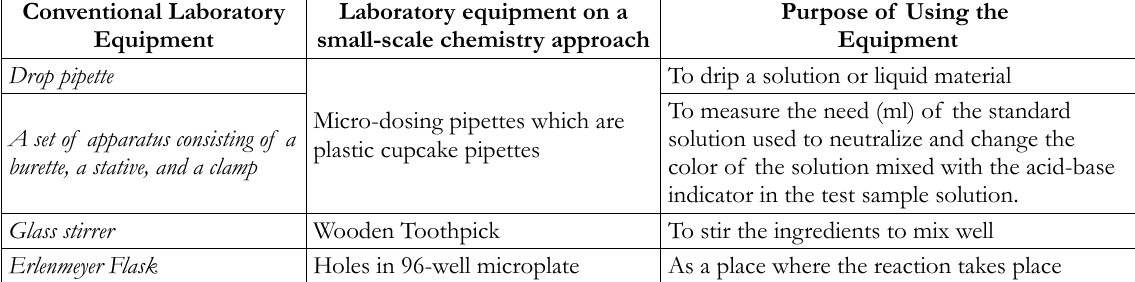
Table 1. Modification of types of equipment for small-scale chemistry practicum activities